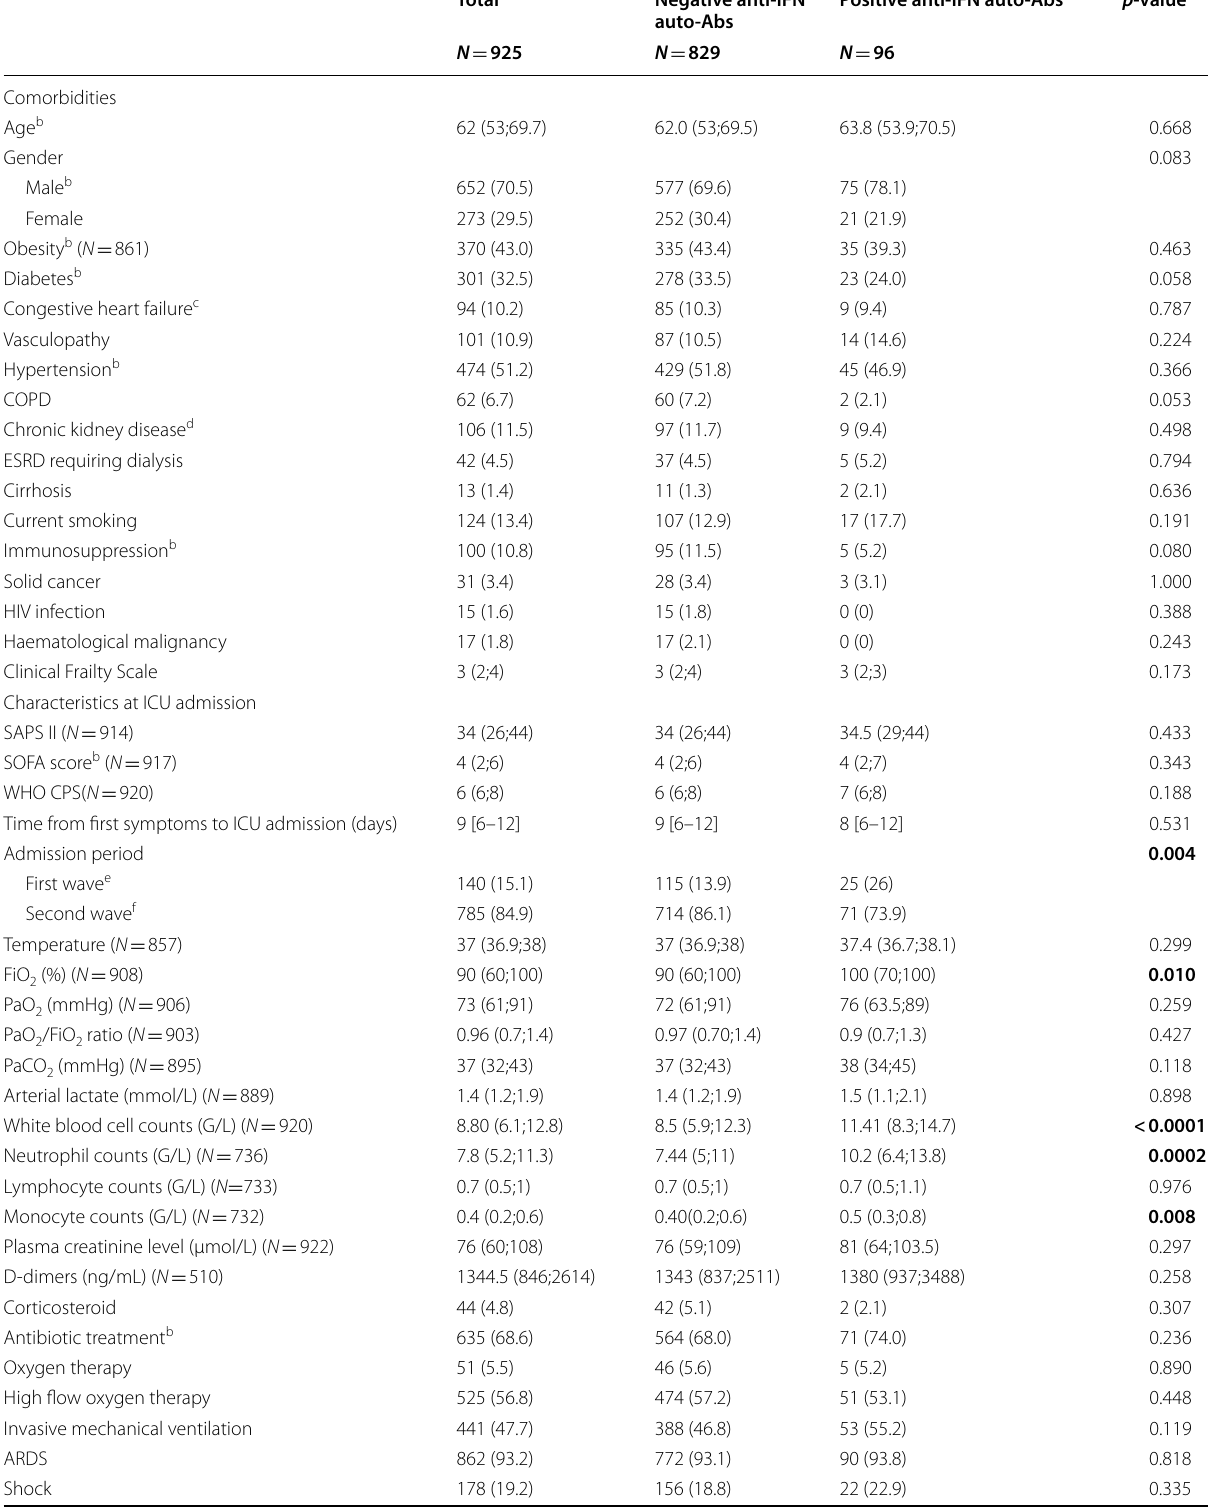
Table 1 Demographics and characteristics of patients with severe SARS‑CoV‑2 infection ( n according to the presence of auto‑antibodies against type I